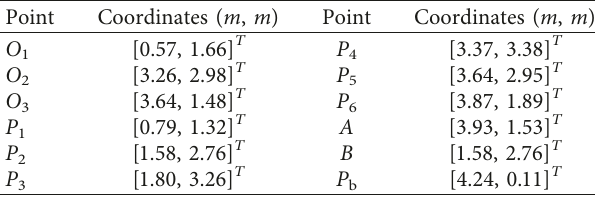
Table 2: Points of the rock-breaker in global